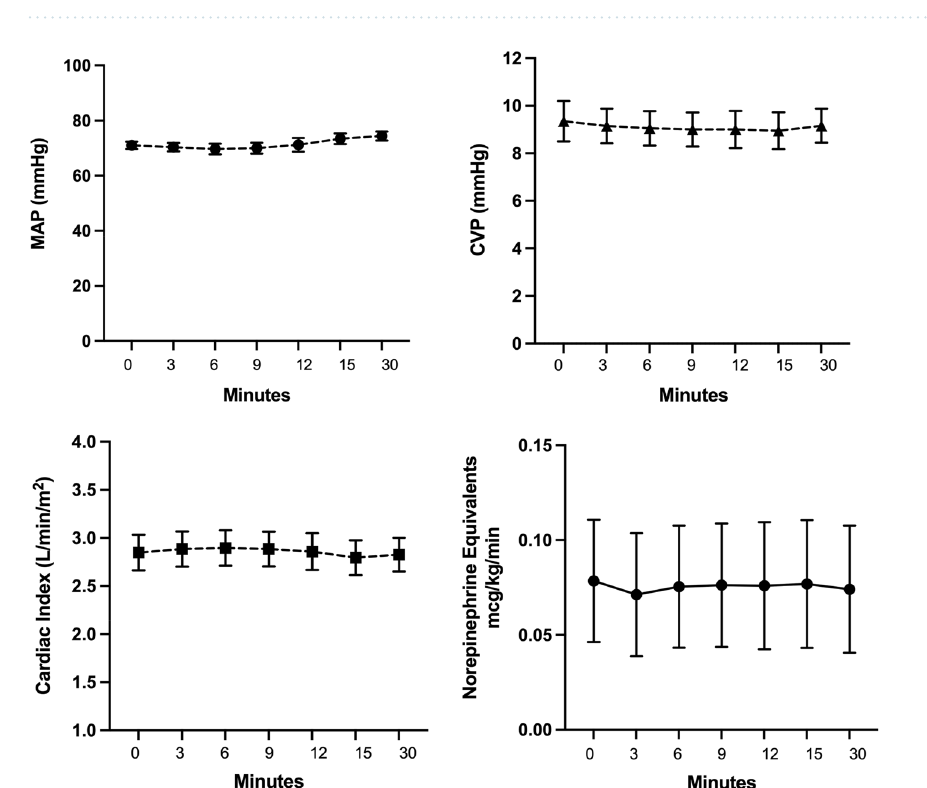
Figure 2. Hemodynamic response to NTG challenge (administration at “minute 0” timepoint). Datapoints represent the mean with SEM for mean arterial pressure (MAP), central venous pressure (CVP), cardiac index (CI), and vasopressor dose reported as norepinephrine